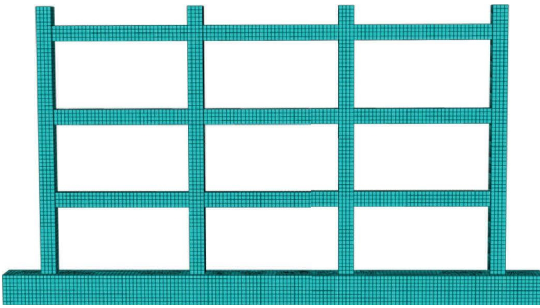
Figure 9: /e established finite element